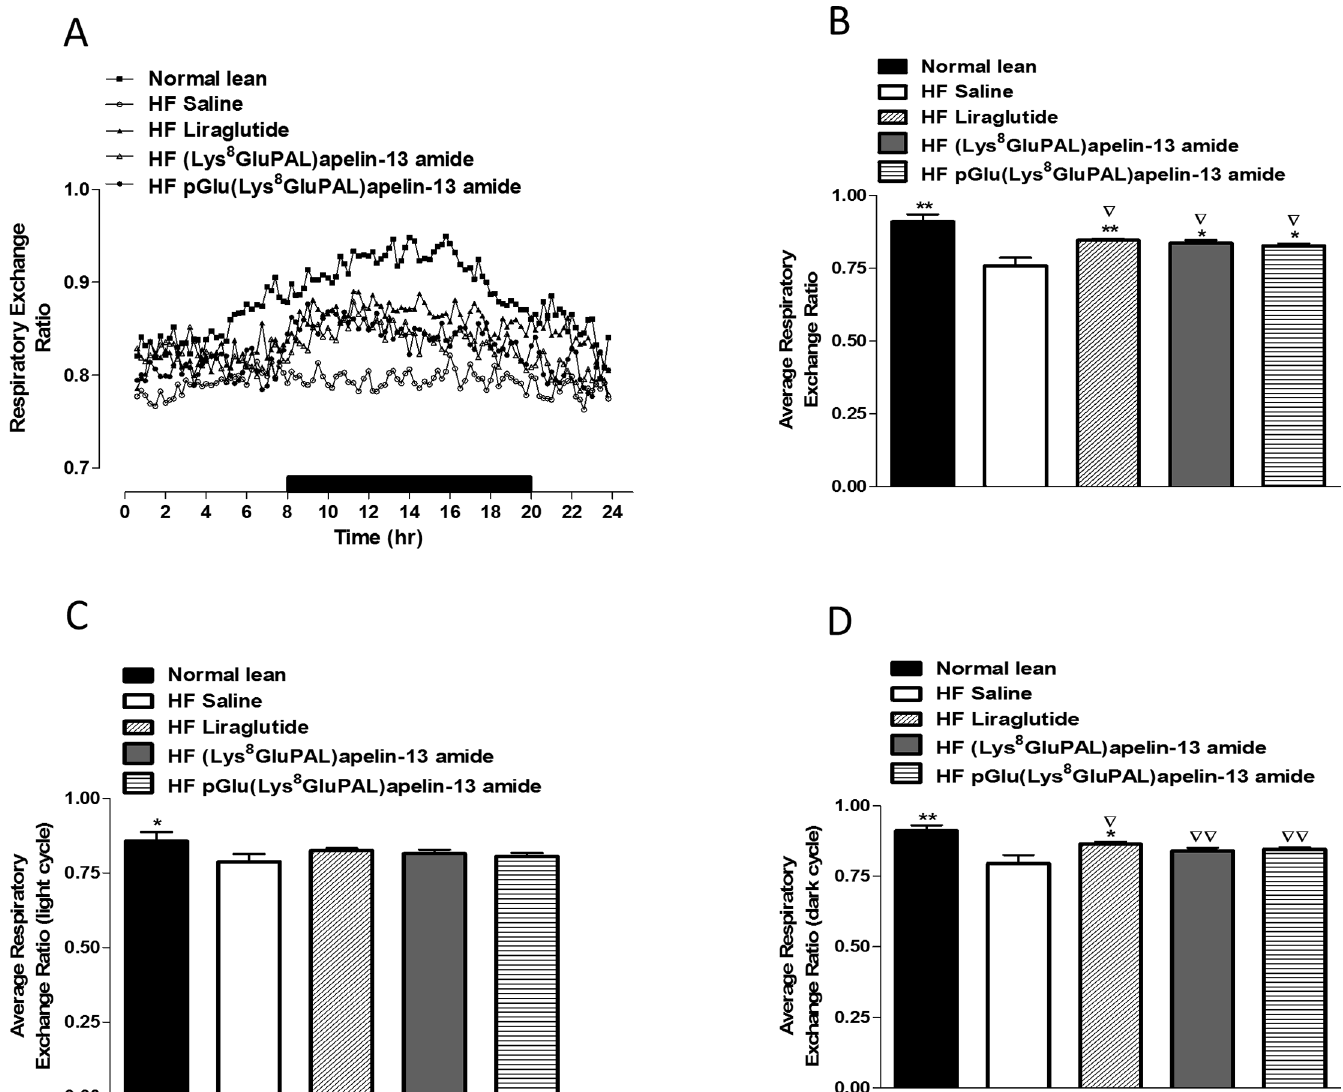
Fig 7. Effect of once daily i.p. administration of liraglutide, (Lys 8 GluPAL)apelin-13 amide or pGlu(Lys 8 GluPAL)apelin-13 amide (each at 25 nmol/kg bw) on respiratory exchange ratio (RER, A). Following 35 days treatment mice were placed in CLAMS metabolic chambers for 24 h (12 h dark period as shown by the black bar). RER was calculated by dividing VCO 2 by VO 2 . Average RER (B), RER in the light (C) and dark cycles (D) are also included. Values represent the mean ± S.E.M. (n = 6) where (cid:3) p < 0.05 and (cid:3)(cid:3) p < 0.01 is compared to high-fat fed saline treated mice and 5 p < 0.05 and 55 p < 0.01 is compared to normal mice.